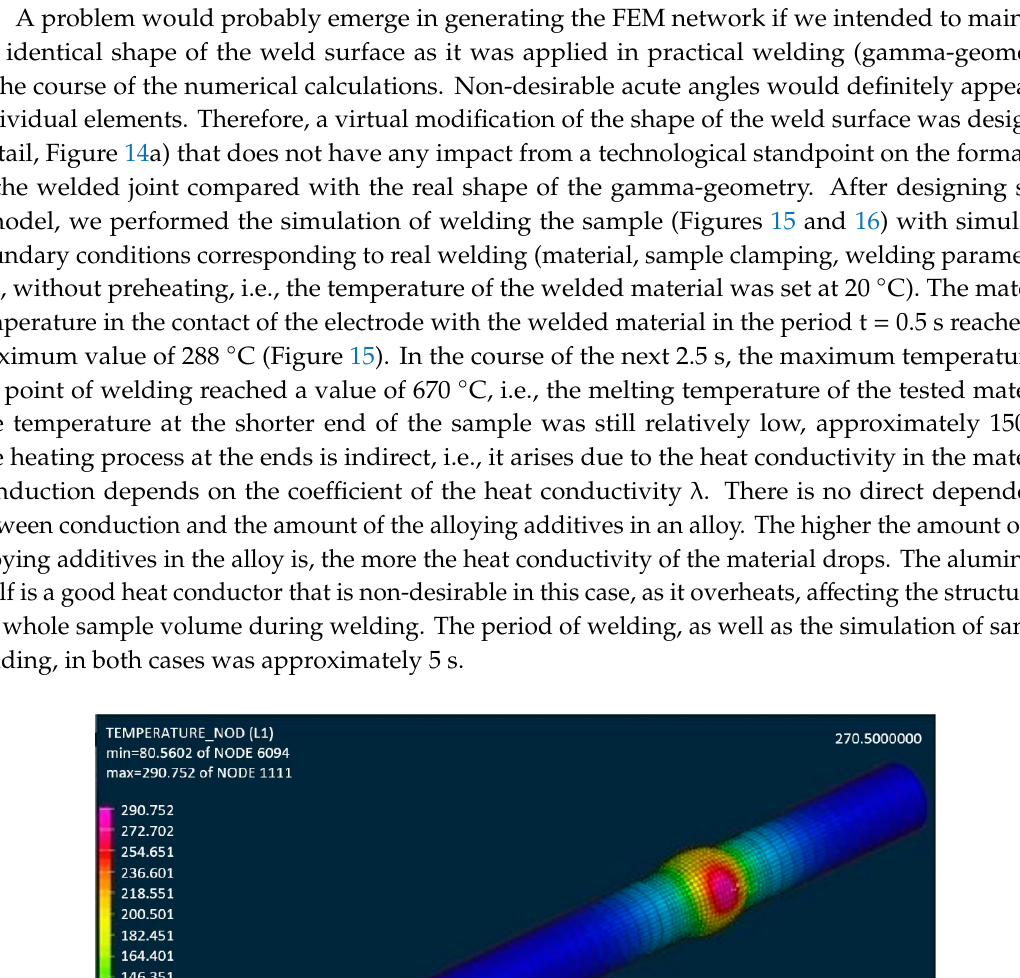
Figure 14. The formation of ( a ) weld surface gamma-geometry and ( b ) the 3D model of the weldment sample, designed in the software SysWeld. sample, designed in the software SysWeld.